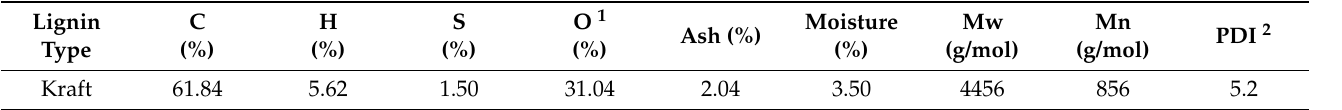
Table 2. Physicochemical properties of the kraft lignin.